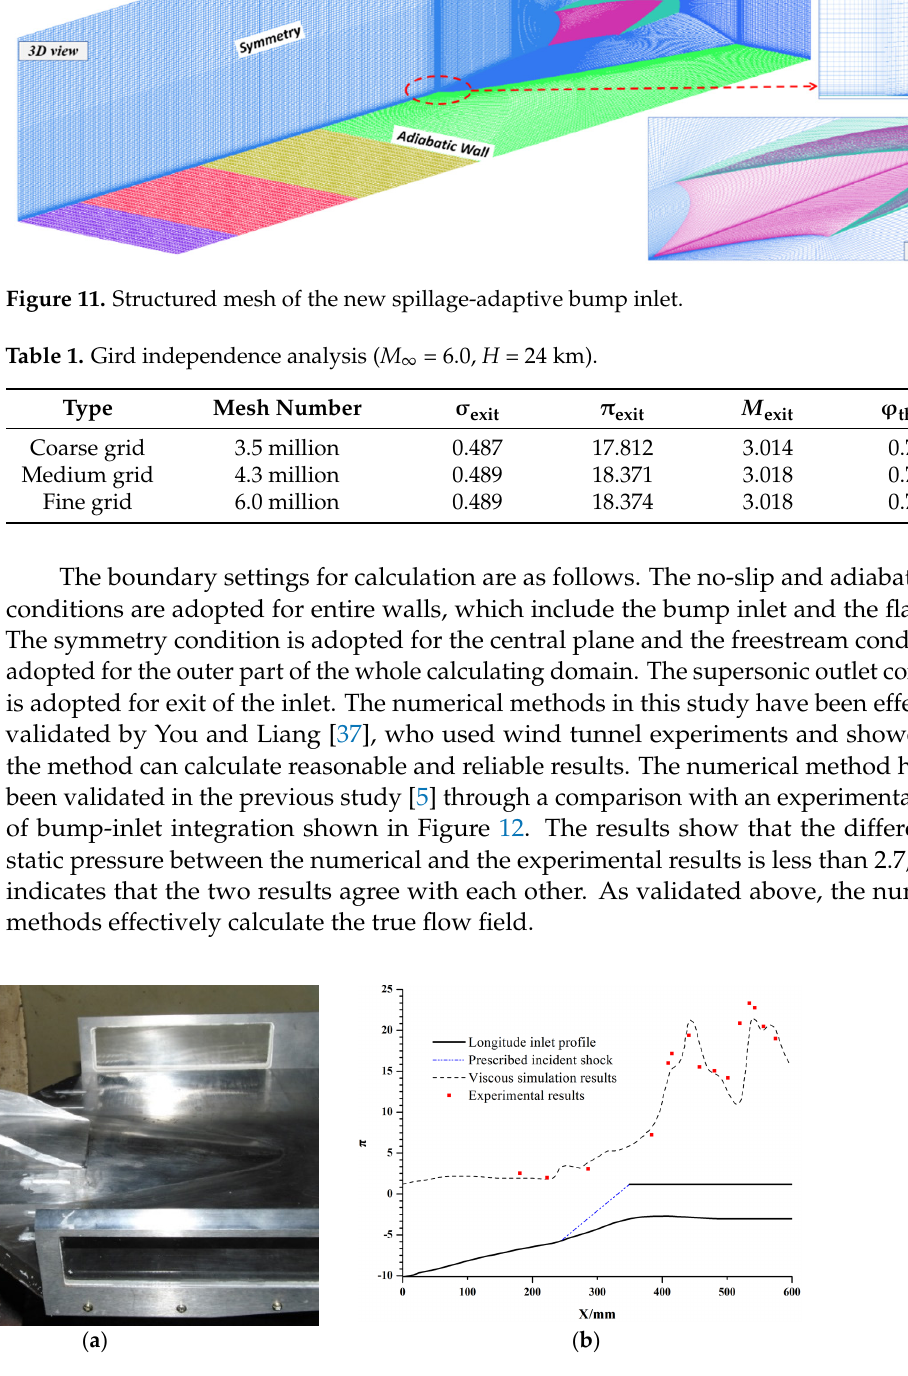
Figure 12. Validation of the numerical methods for the bump inlet integration (( a ) M6 scaled wind tunnel test; ( b ) longitude pressure distribution of the experimental and numerical results).